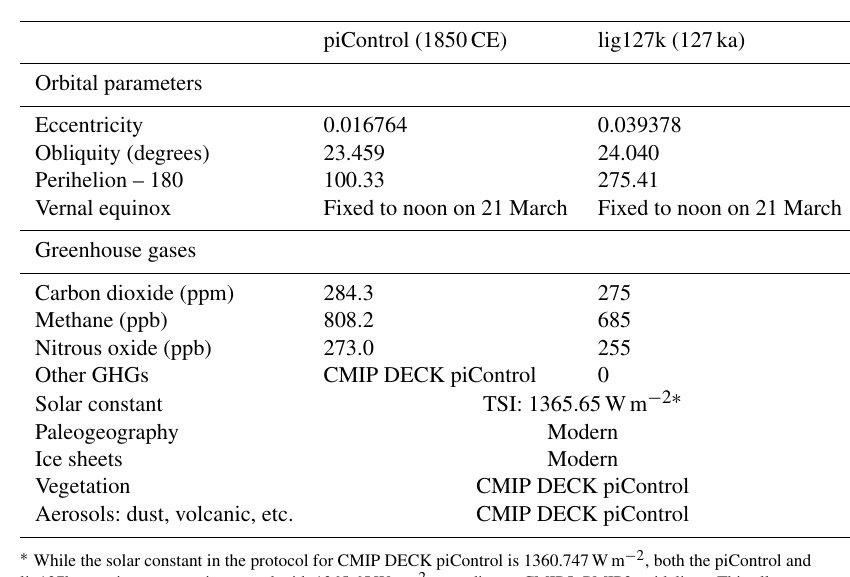
Table 1. Forcings and boundary conditions of the piControl and lig127k experiments.